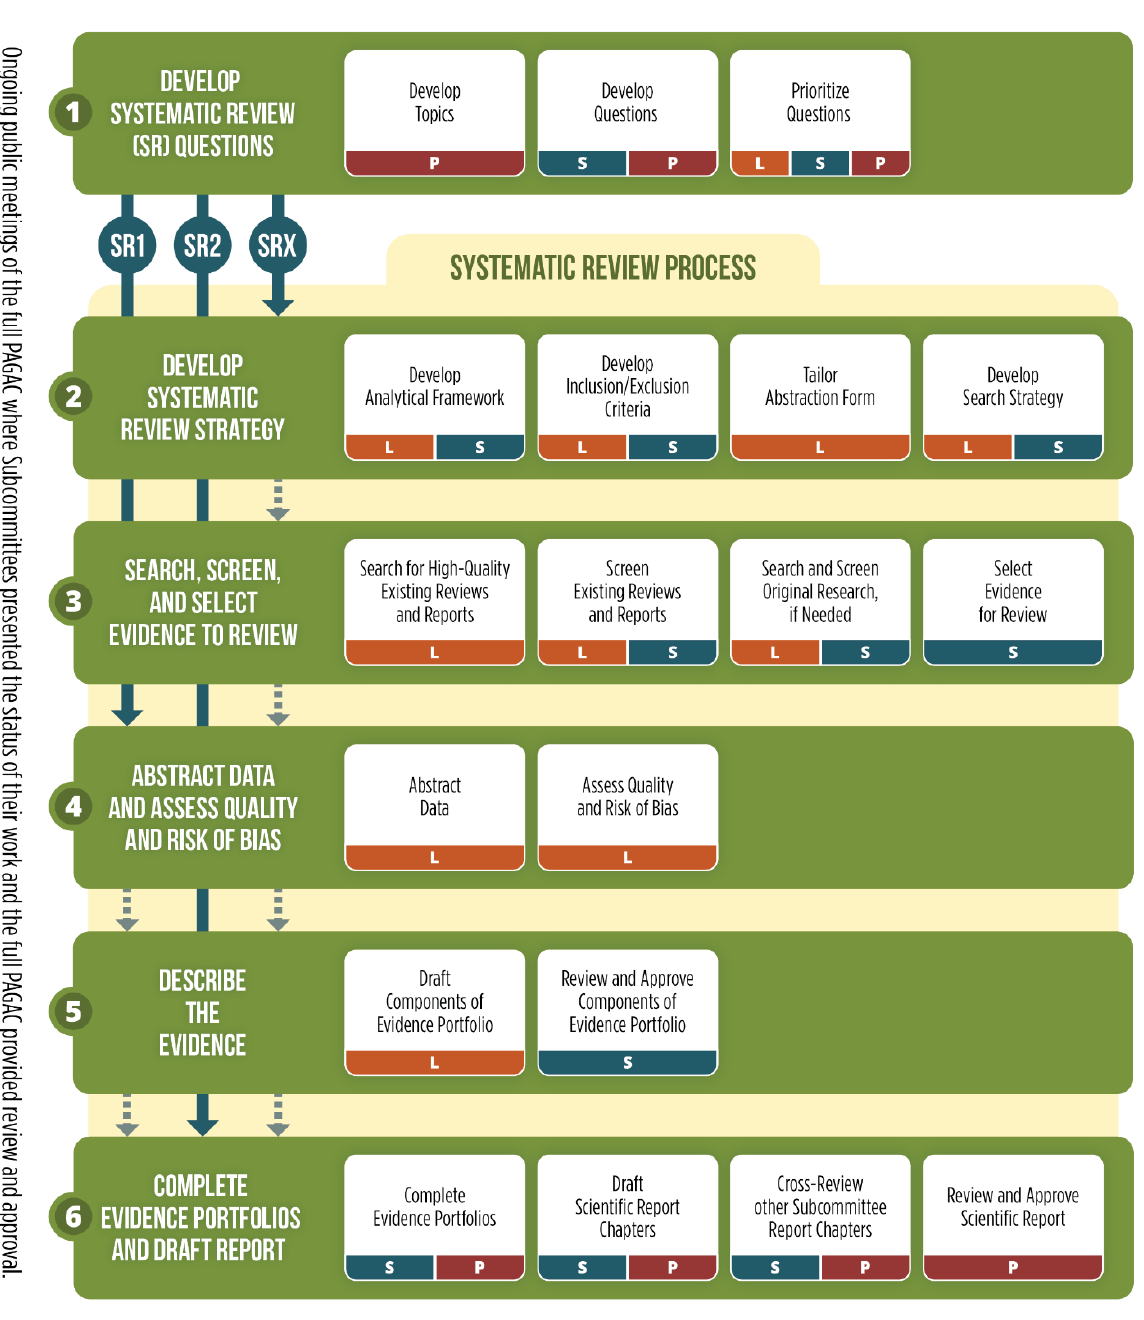
Figure E-1. 2018 Physical Activity Guidelines Advisory Committee Process